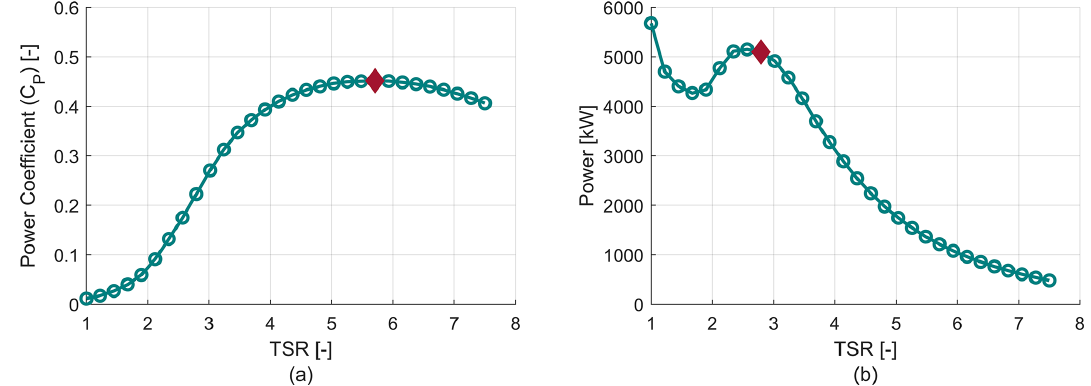
Figure 4. (a) Examples of a C P vs. tip speed ratio curve used for stage 1 of the analysis. (b) Example of power vs. TSR curve for stage 1. The maximum C P and the stall point are indicated by red markers.